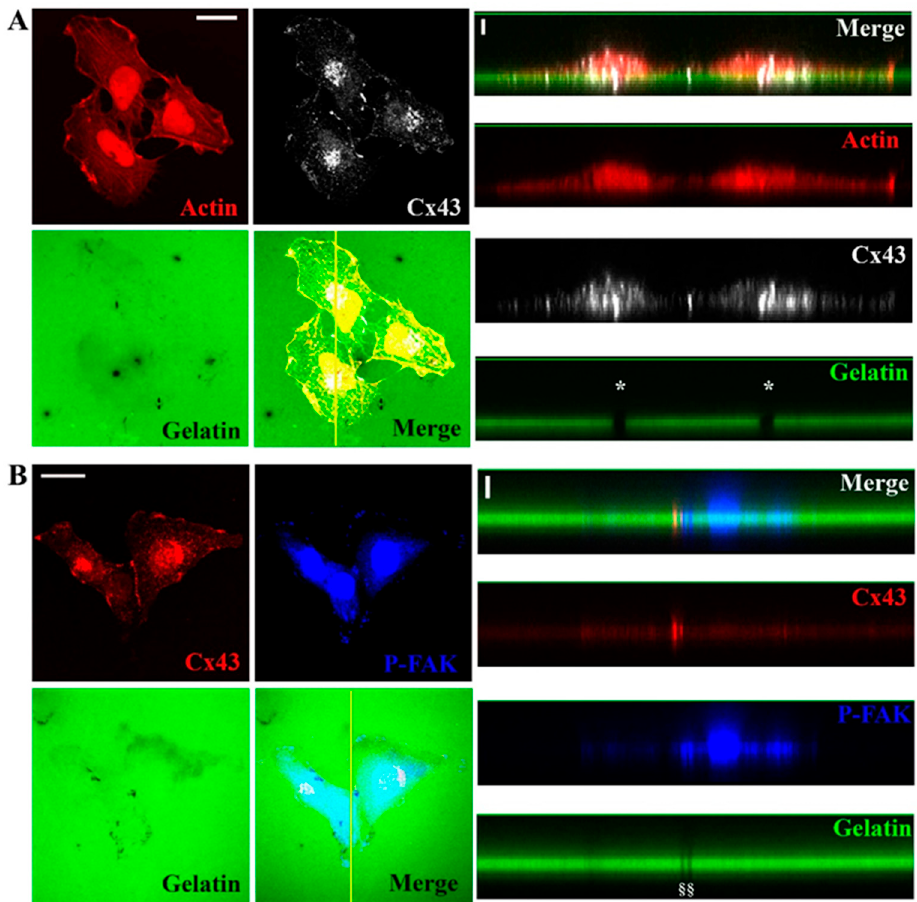
Figure 2. U251 cells form invadopodia containing Cx43. Cells were cultured on coverslips coated with FG-gelatin (1.5 × 10 4 cells/mL) and observed by confocal microscopy in the xy dimension. After 5 h, localization of ( A ) F-actin (Red) and Cx43 (White) or ( B ) Cx43 (Red) and P-FAK (Blue) was determined by indirect immunofluorescence or using TRITC-phalloidin. Invadopodia formation (*) and focal adhesions (§) were observed. Each left panel is xy images, the right top panel is xz images and the right bottom panel is an xz enlargement of the regions of interest (N = 10). The yellow line in the xy images is the axis shown in the xz images (Scale bar: 20 µm on xy dimension and 2 µm on xz dimension).